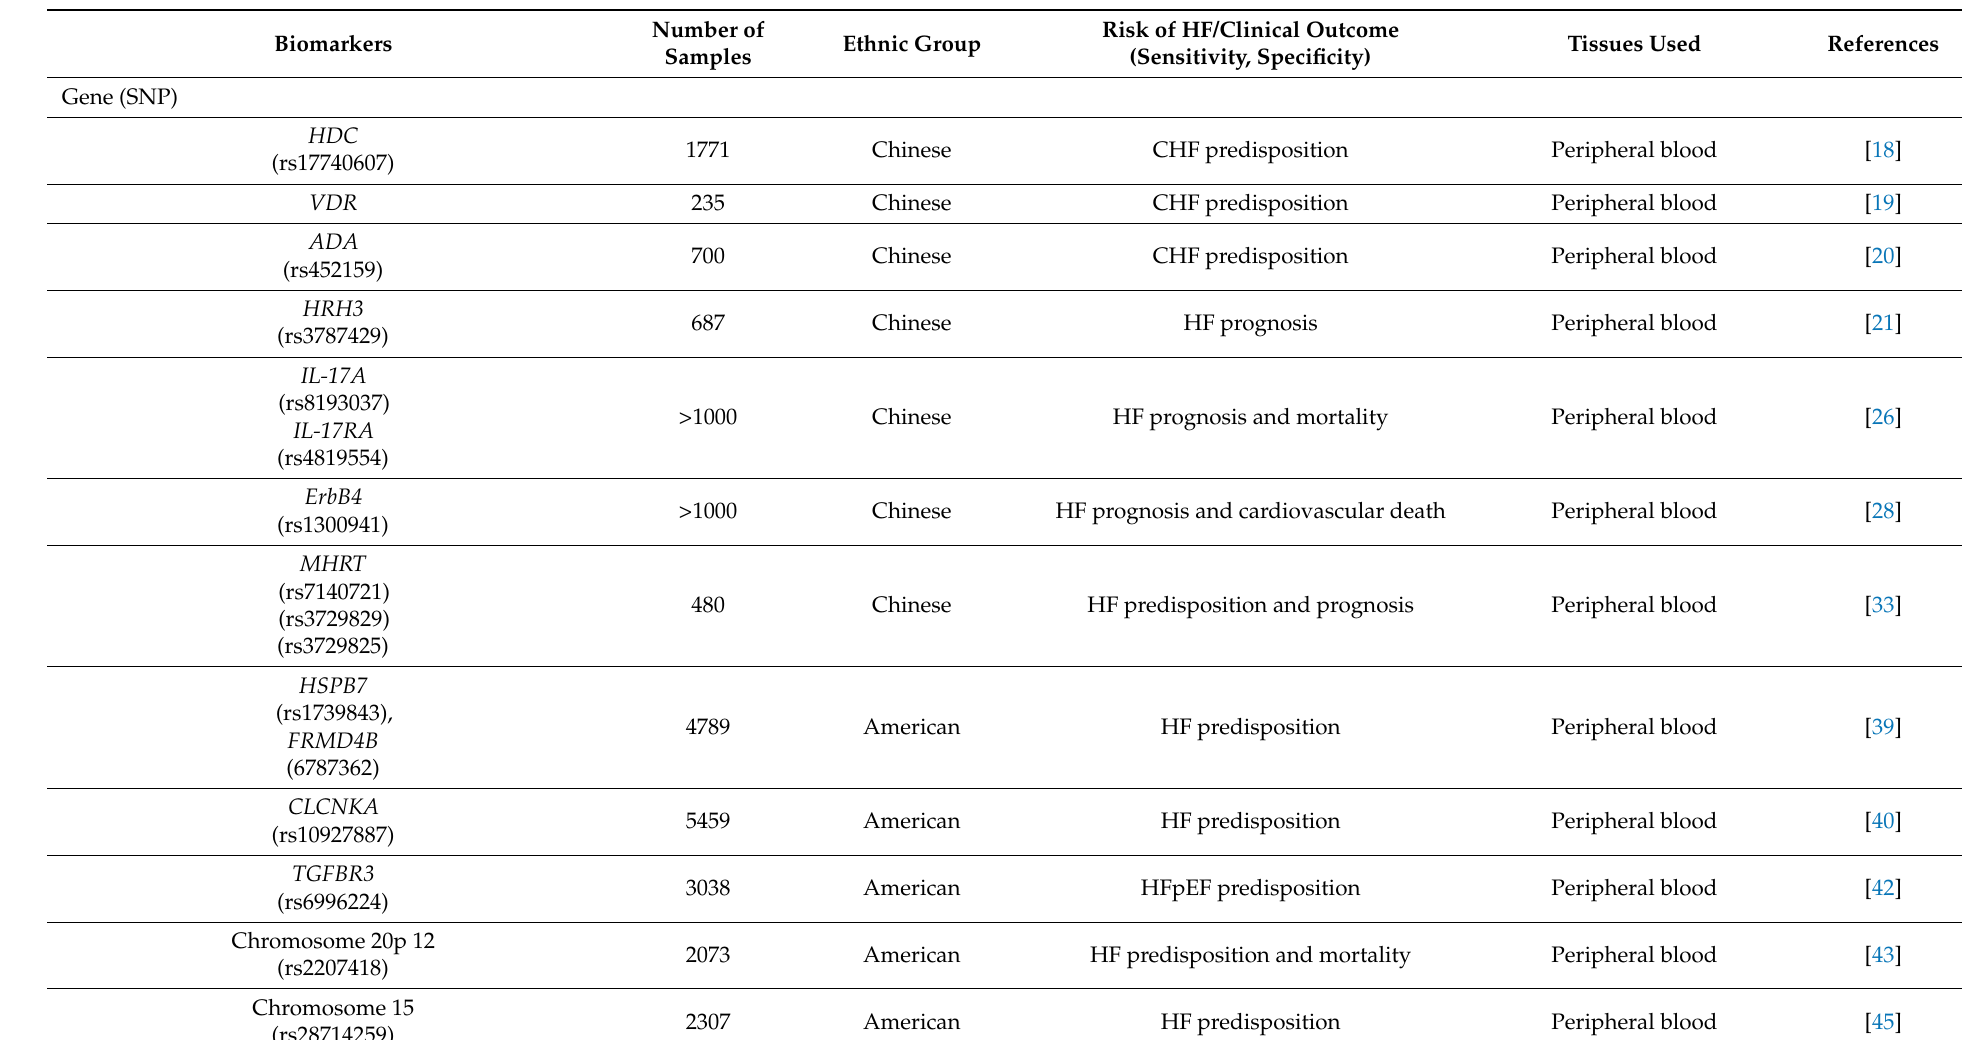
Table 2. List of potential biomarkers of heart